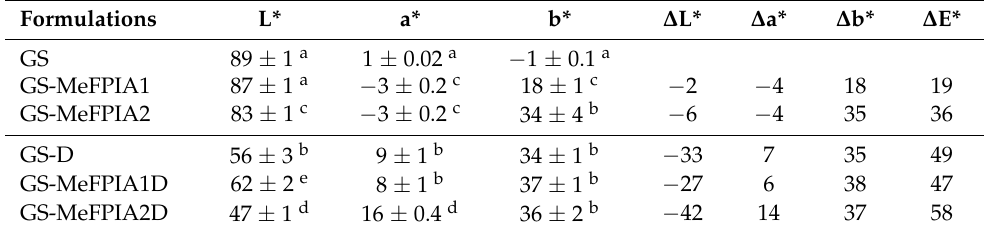
Table 3. Color properties of gelatin-based films. Formulations